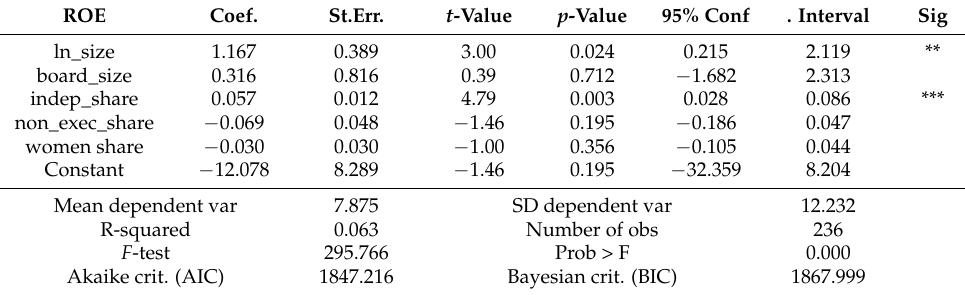
Table 4. OLS Regression Results with Board Characteristics.